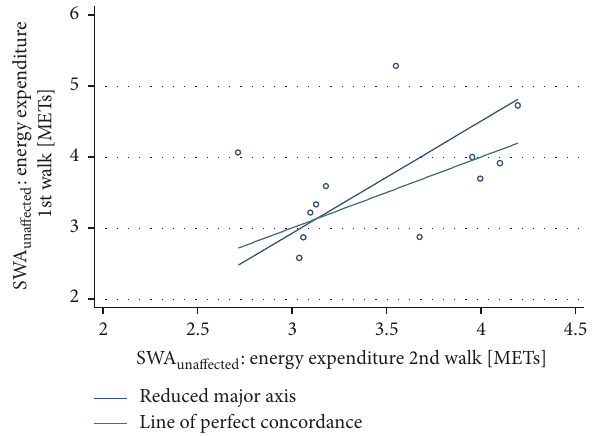
Figure 4: Energy expenditure SWA unaffected : 1st and 2nd bout of sit-